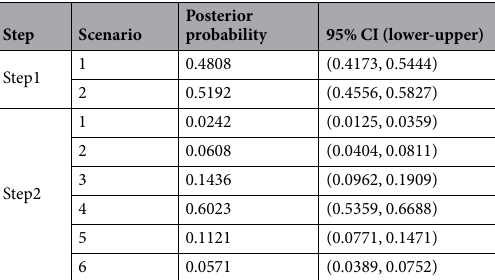
Table 5. Description of the scenarios used in the approximate Bayesian. Computation analysis in DIYABC to test the source and the differentiation time among species. The relative posterior probabilities and 95% confidence intervals for each scenario were computed via the logistic regression on 1% of the closest data sets to the observed